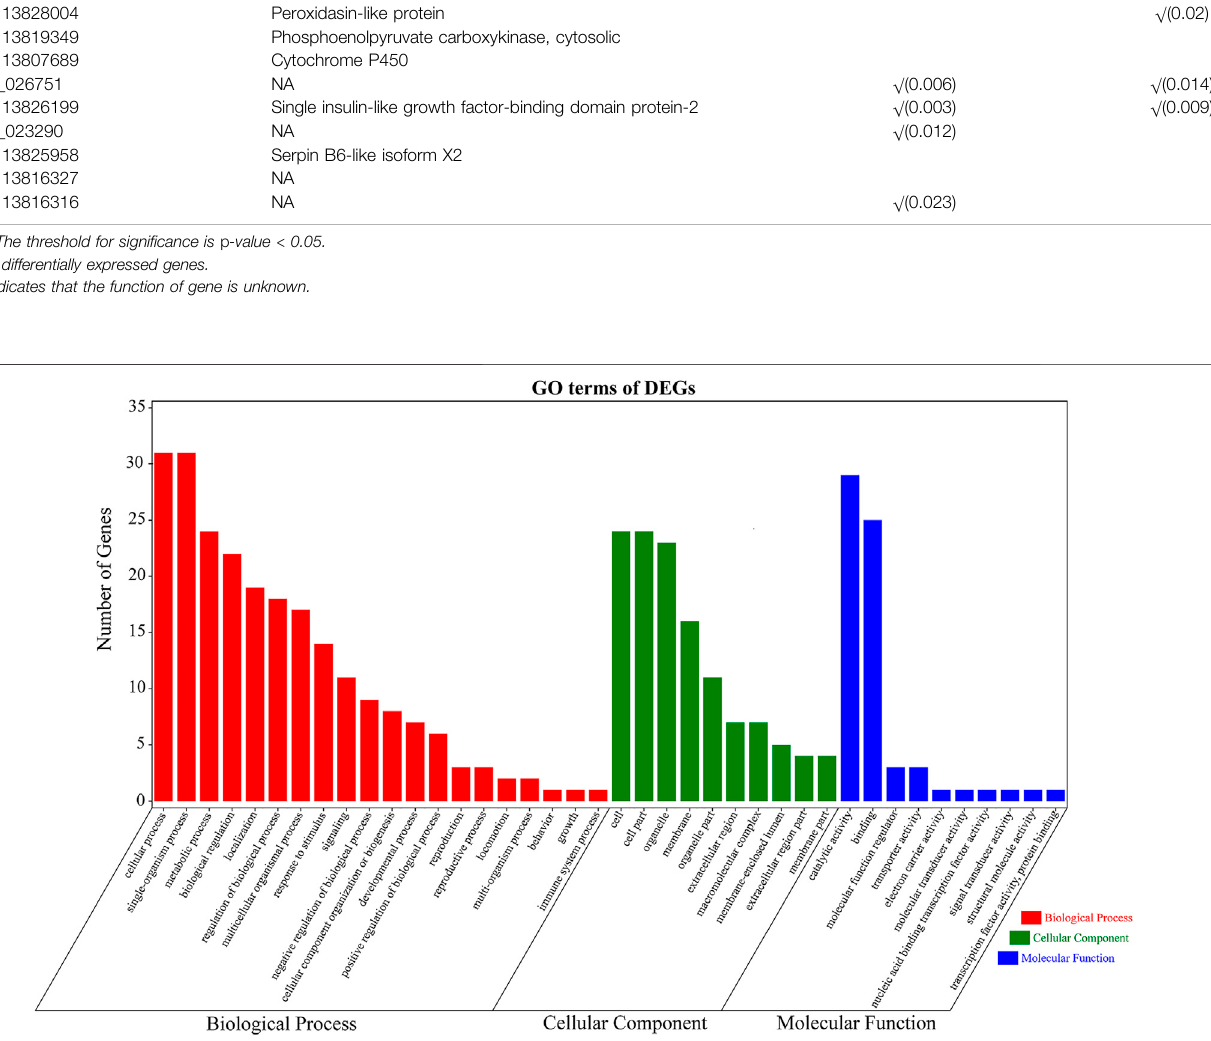
Frontiers in Genetics |